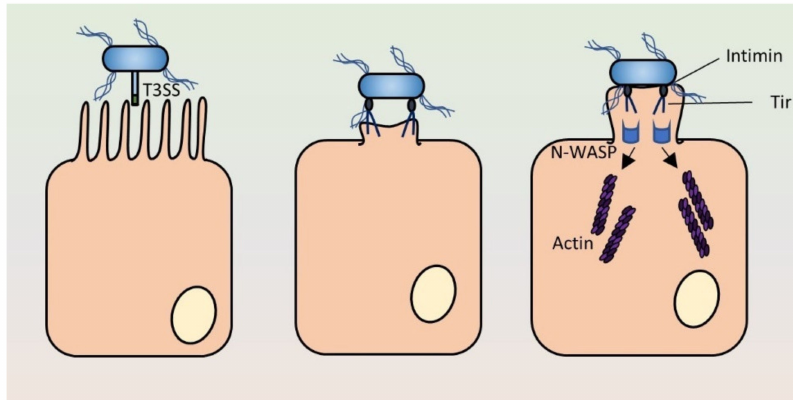
Figure 3. Schematic of the major steps in pedestal formation by attaching and e ff acing pathogens. The bacteria initially bind to the enterocytes via adhesins, allowing the Esc T3SS to inject e ff ector proteins. These include Tir, which is inserted into the plasma membrane of the target cell where it binds to the inverse autotransporter intimin, present on the bacterial surface. The binding of intimin to Tir leads to intimate attachment and Tir clustering, resulting in recruitment of N-WASP, actin rearrangements and pedestal formation. Thus, the LEE-encoded T3SS and T5SS (intimin) act together to form the A / E lesion.